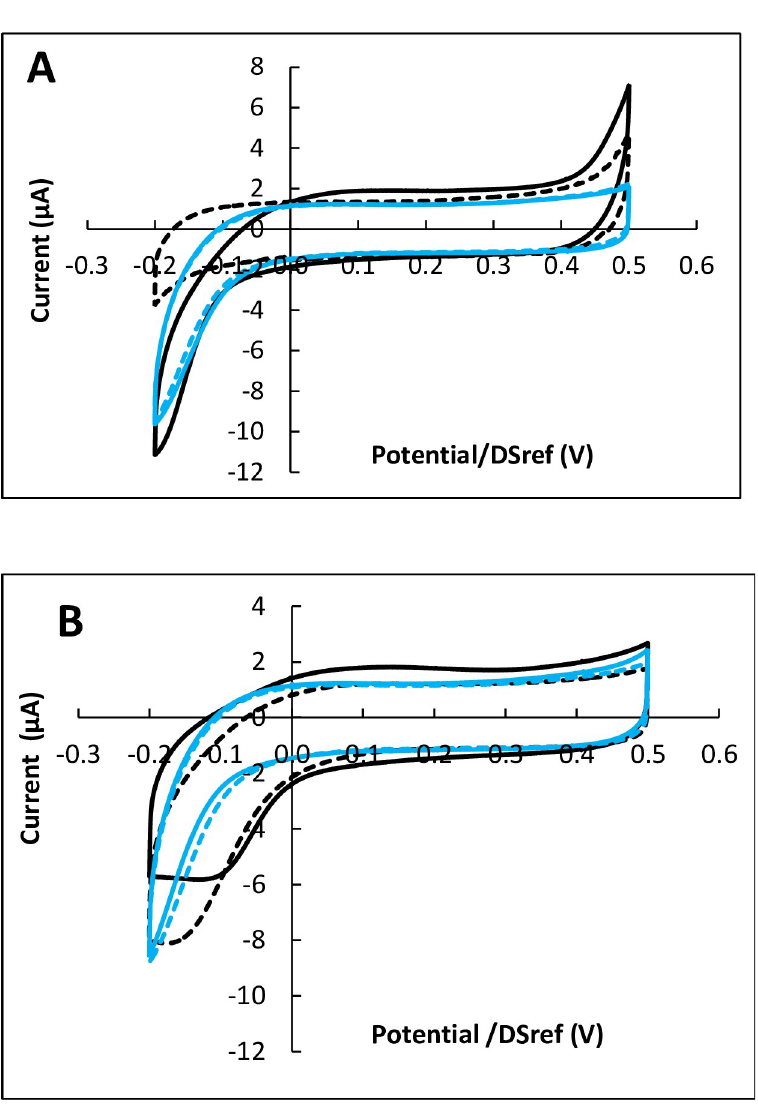
Fig 2. Cyclic voltammetry of Vero cells on carbon electrodes after 48 and 72 hours of incubation. Potential scan rate 10 mV.s -1 . A) 48 hours, B) 72 hours. Black: with cells; blue: controls without cells; in each case dotted lines are duplicates. Potentials are expressed vs. the DropSens pseudo-reference (DSref), values vs. SHE can be obtained by adding 0.290 V.